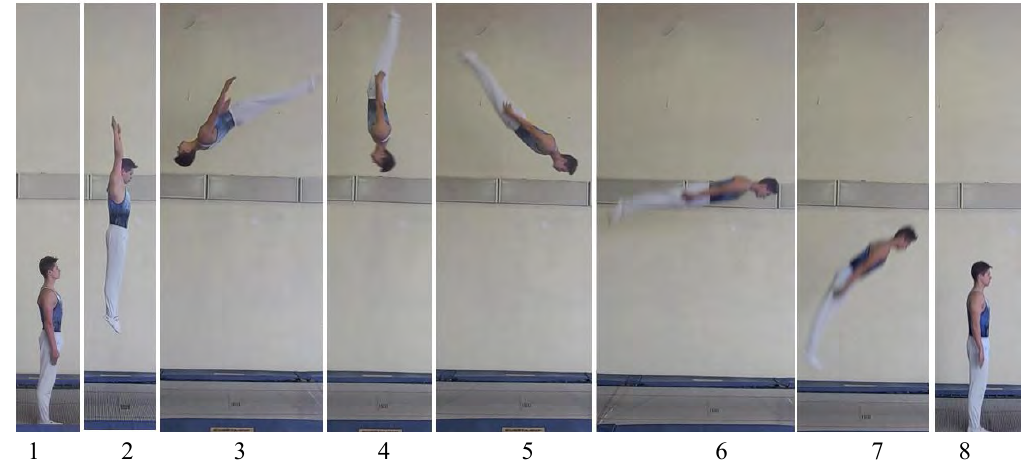
Fig.11. Back somersault, straightening